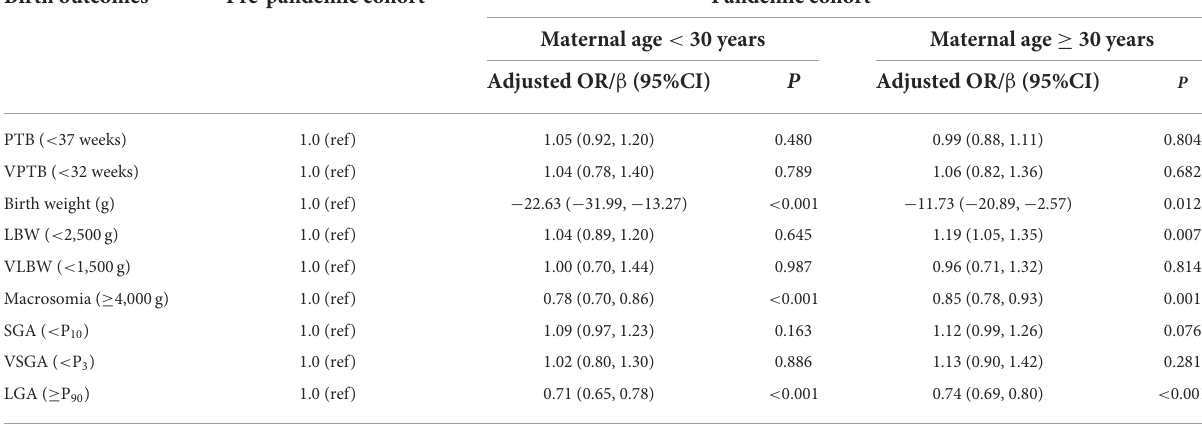
TABLE 3 Stratified analyses on the association between COVID-19 pandemic and birth outcomes by maternal age. Birth outcomes Pre-pandemic cohort